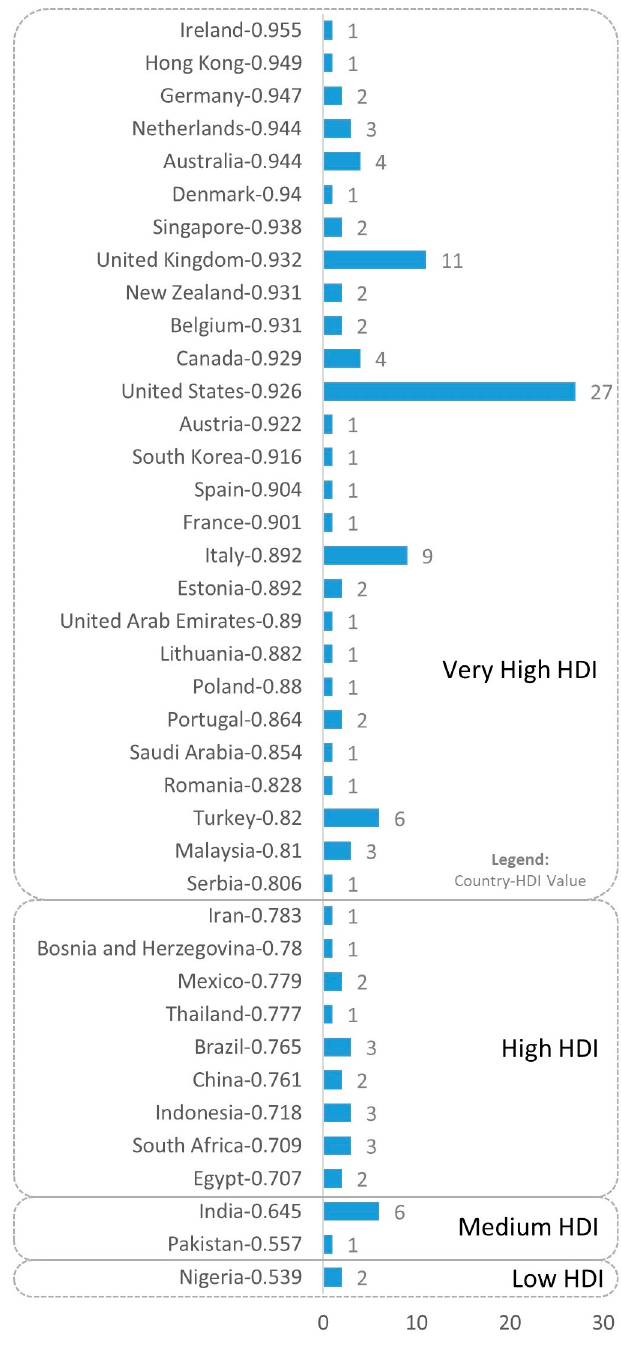
Figure 1. Regional affiliation of survey respondents.